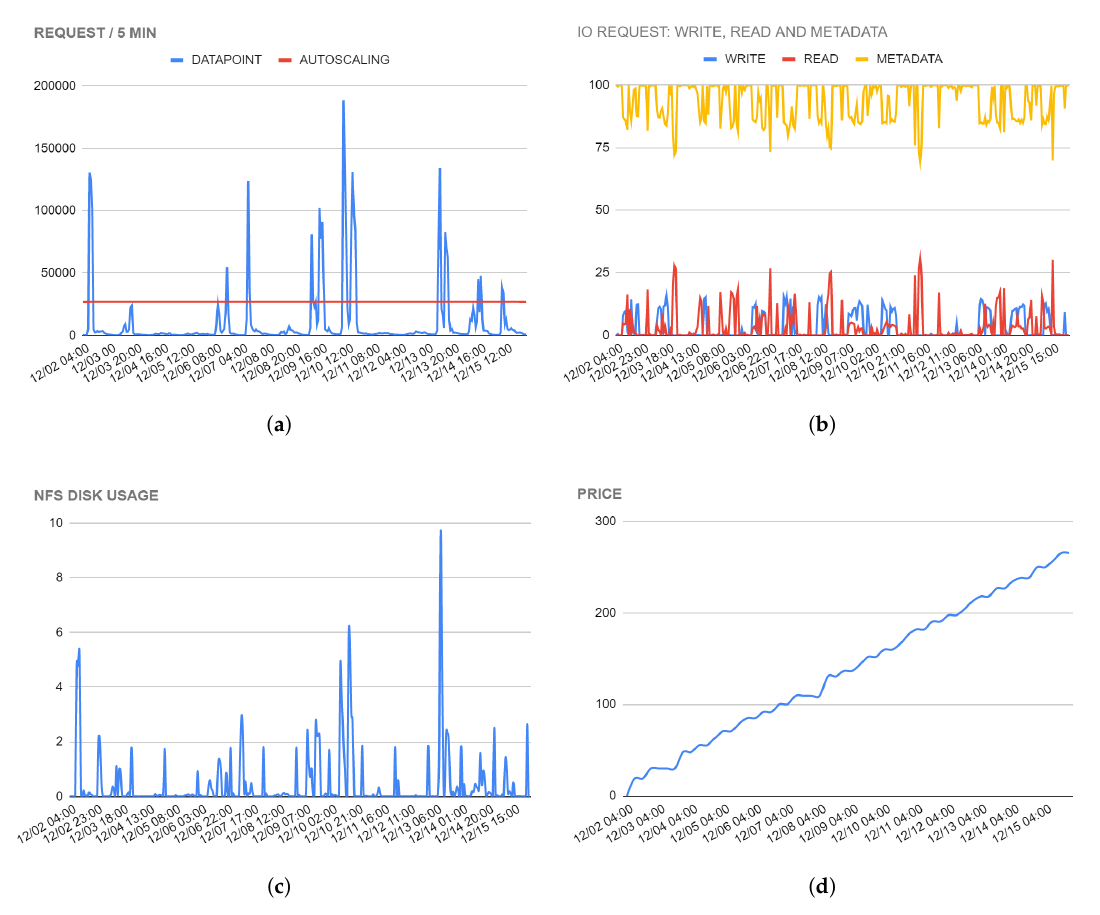
Figure 4. Input output request and price chart. ( a ) average number of requests received in the considered range of two weeks and a sampling time of 5 min; ( b ) type of input output requests to the network drive; ( c ) percentage of shared network file system usage; ( d ) graph showing costs trend over two weeks of